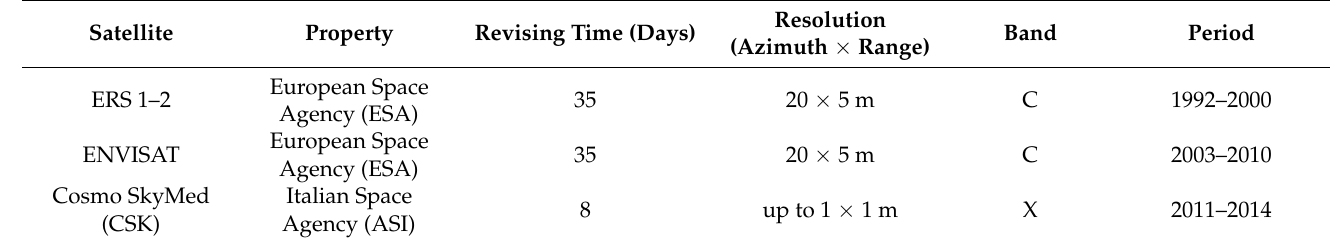
Table 3. Characteristics of the satellite